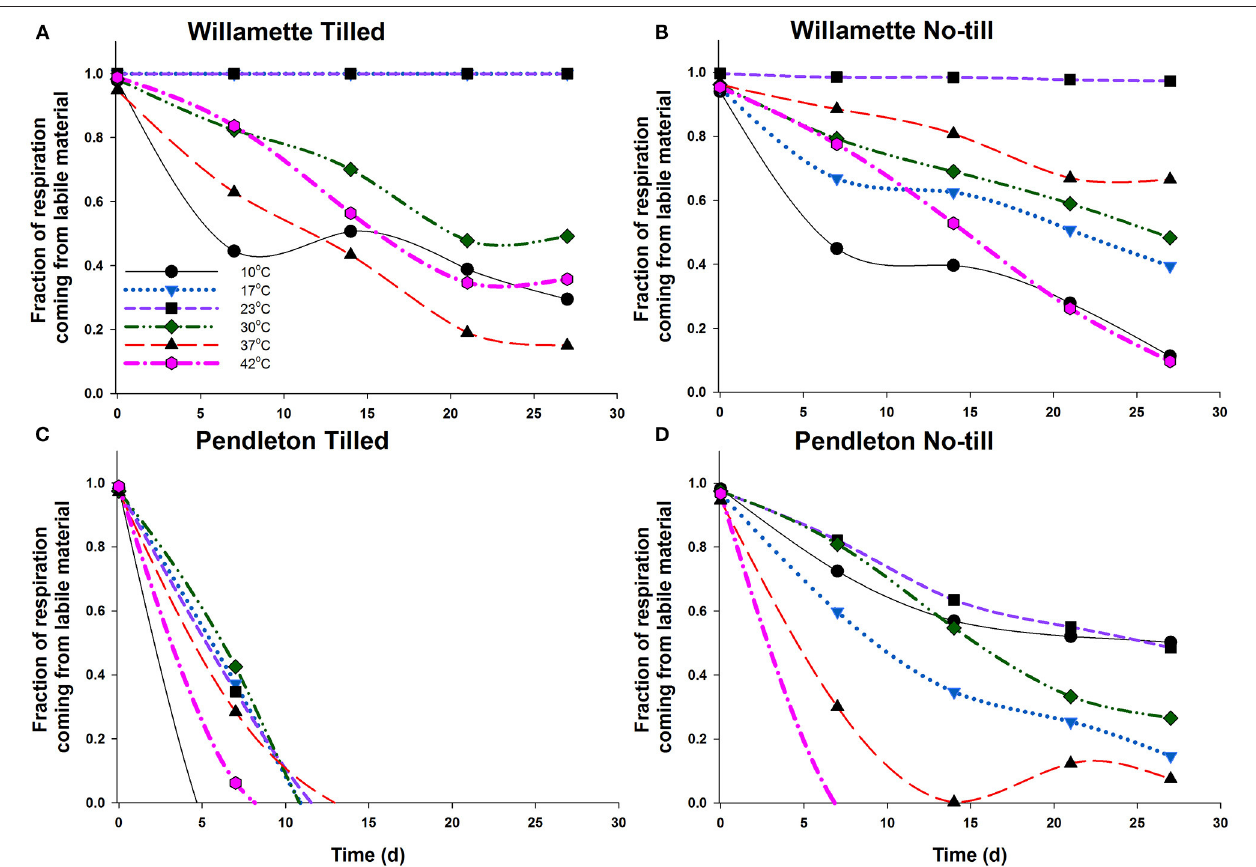
FIGURE 5 | Fraction of the respired CO 2 contributed by the labile SOM pool in Willamette Tilled (A) , Willamette No-till (B) , Pendleton Tilled (C) , and Pendleton No-till (D) soils. The two pool conceptual model estimates of the amount of CO 2 contributed by the labile SOM pool as the soil incubation progressed. Lines represent the average of three soil replicates. Error bars were omitted to aid